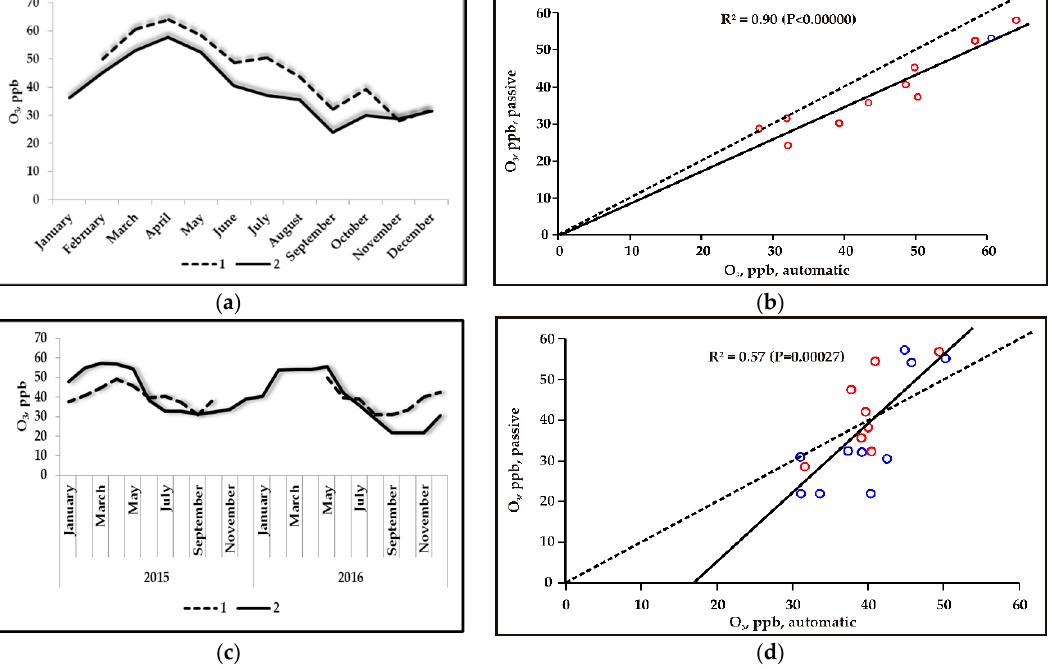
Figure 4. Comparative analysis of ozone concentrations sampled using the passive method and measured in the atmosphere at the Listvyanka ( a , b ) and Mondy sites ( c , d ). 1—Automatic method; 2—Passive method. In the figures ( b , d ), the red circles show the data obtained with a two-week exposure of the passive sampler, while the blue circles show the data obtained with the monthly exposure of the passive sampler. The solid line is a plot of the evaluated regression model, and the dotted line is the expected relationship with slope = 1 and intercept = 0. The value of the quality of the linear approximation R 2 and its statistical support P are shown in the figure.